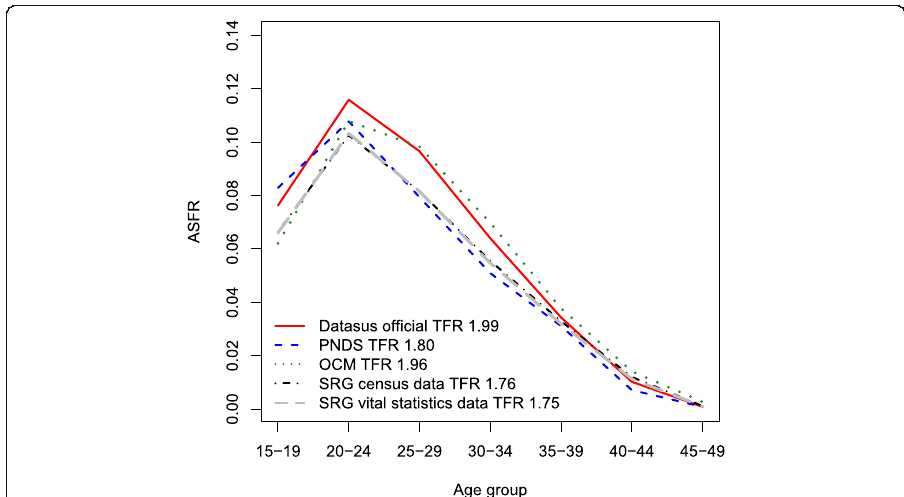
Fig. 3 Fertility schedules estimated by different methods and different data sources, Brazil, 2005. Source: PNDS 2006 and Brazilian censuses and vital registration 2000 –